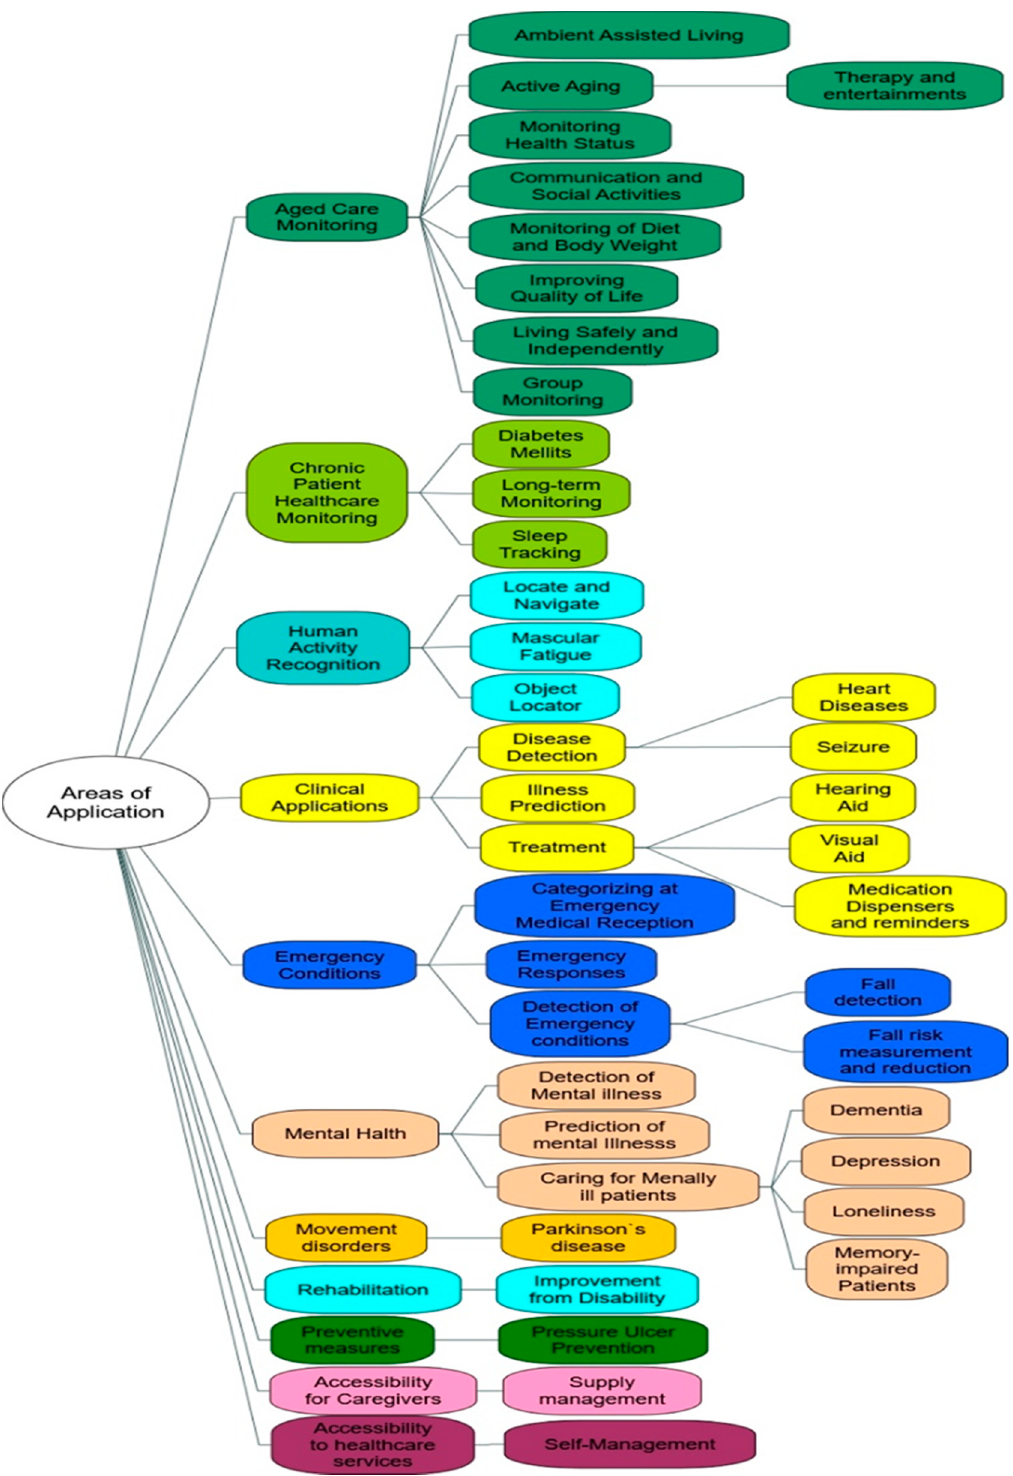
Figure A1. The hierarchy of IoT applications for elderly healthcare [7].